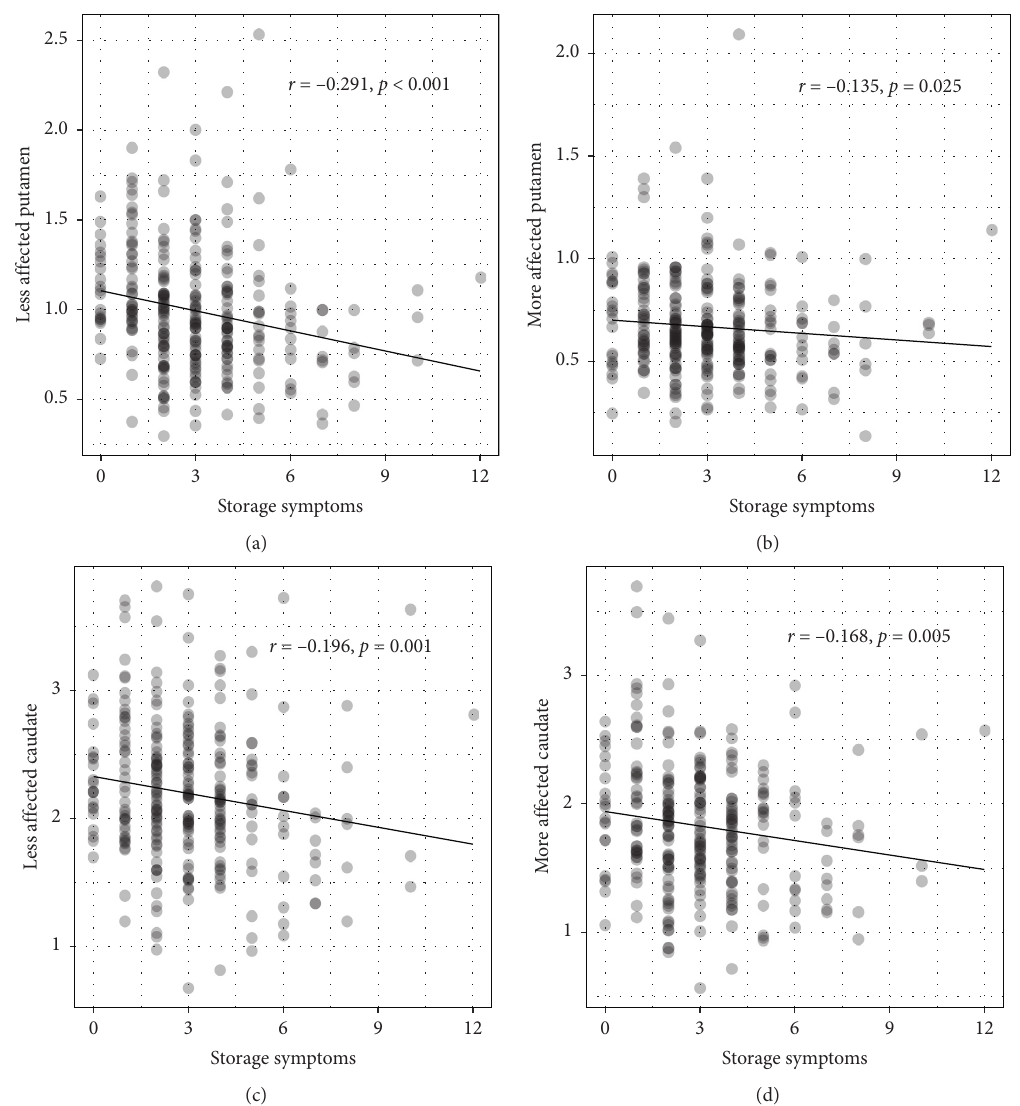
Figure 1: Spearman correlation between storage symptoms and DAT binding levels in (a) the less affected side of the putamen; (b) the more affected side of the putamen; (c) the less affected side of the caudate; and (d) the more affected side of the caudate in